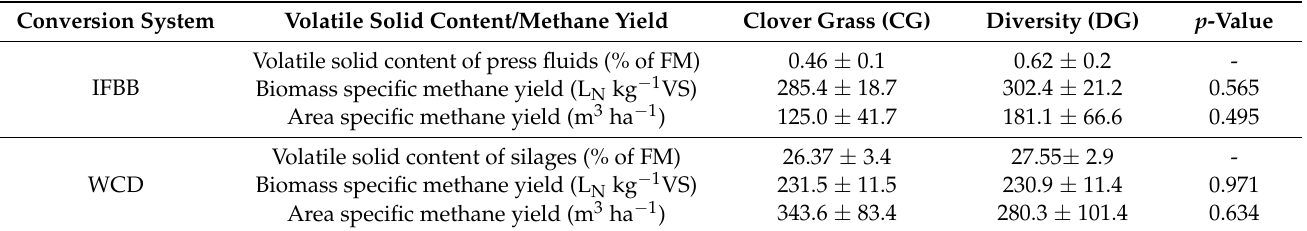
Table 3. Arithmetic mean ± standard error of mean of volatile solid content of press fluids and silages, biomass-specific methane yield and area-specific methane yield for press fluid from integrated generation of solid fuel and biogas from biomass (IFBB) and whole crop digestion of silage (WCD) of two different alley cropped grassland mixtures and p -value of the ANOVA testing the effect of biomass type on biomass and area specific methane